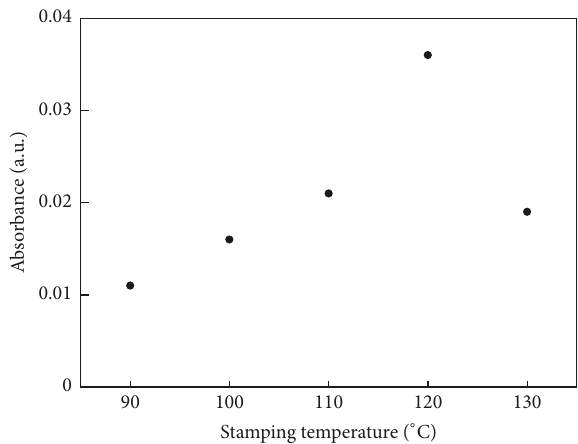
Figure 4: Peak absorbance at 390 nm of TPBi as a function of stamping temperature.